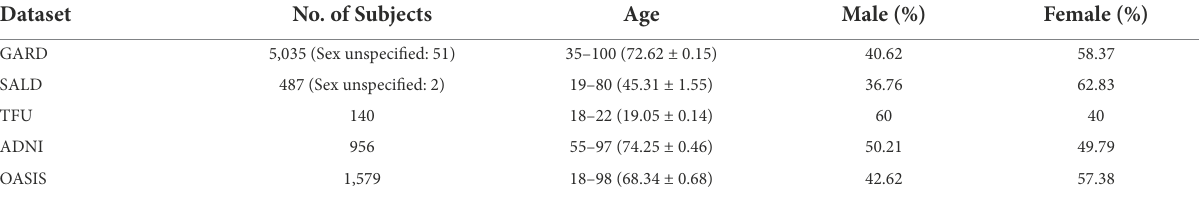
TABLE 1 Characteristics of study samples.